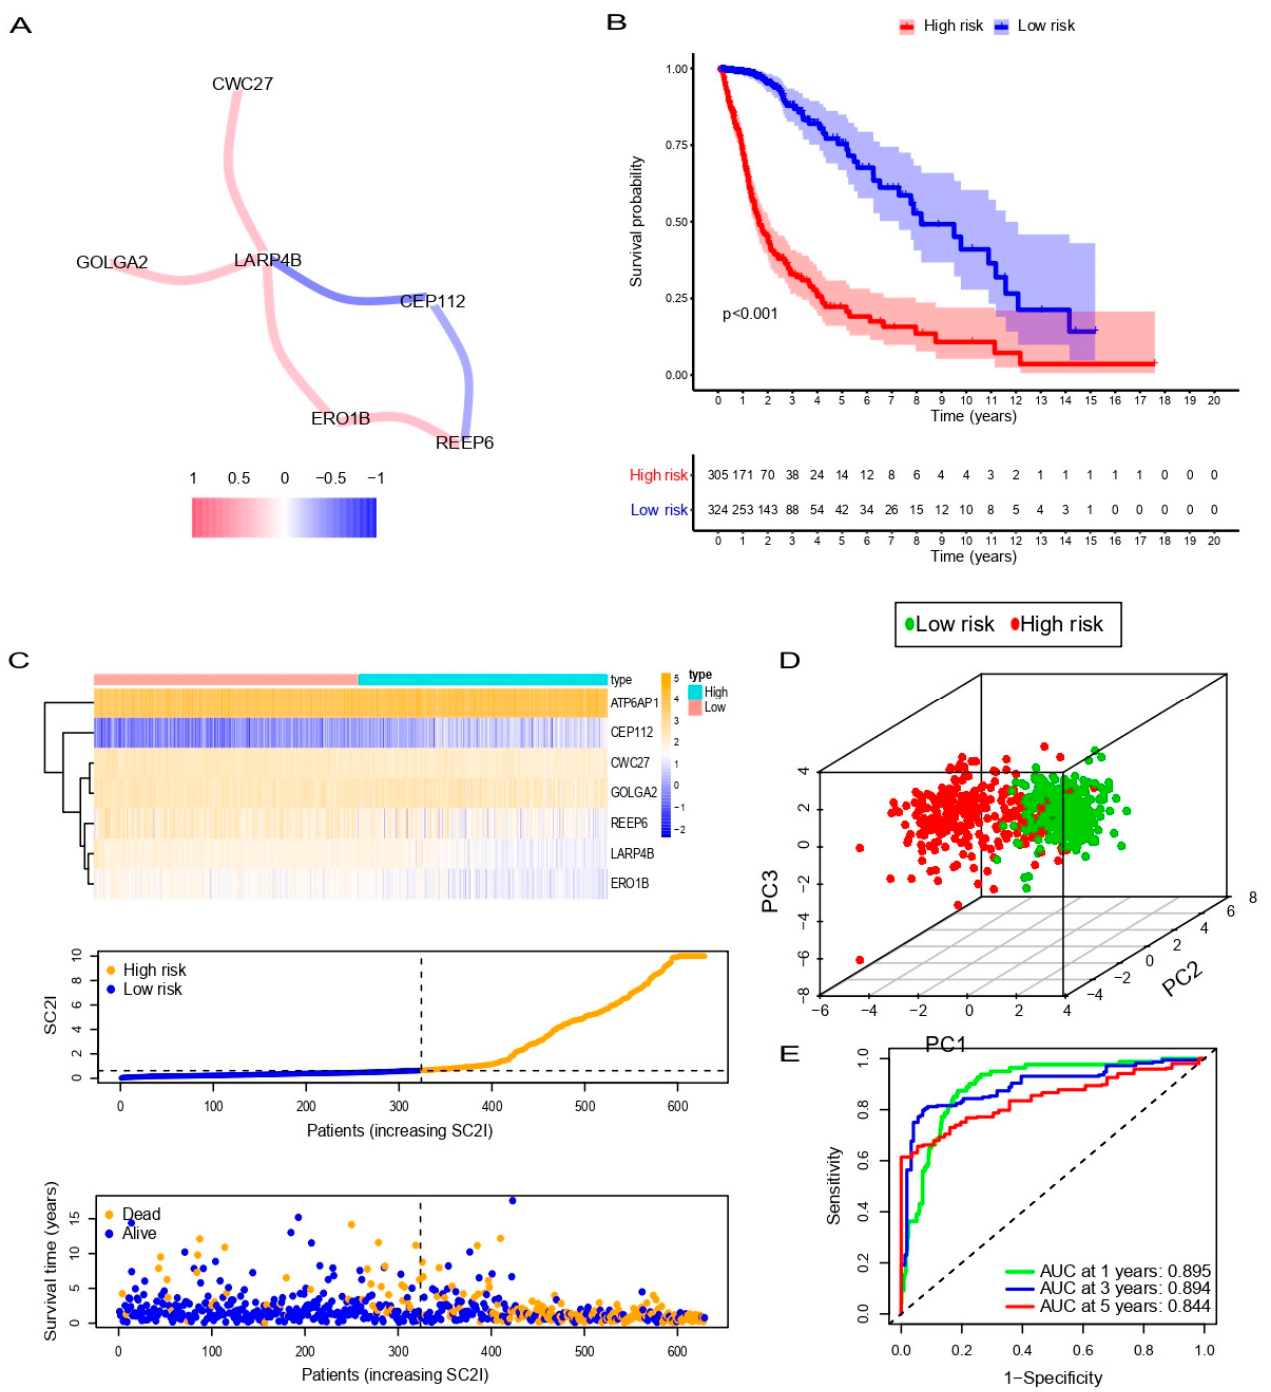
Figure 3A, with positive correlations in blue and negative ones in red. The survival curves of each gene are shown in Supplementary Figure S3.